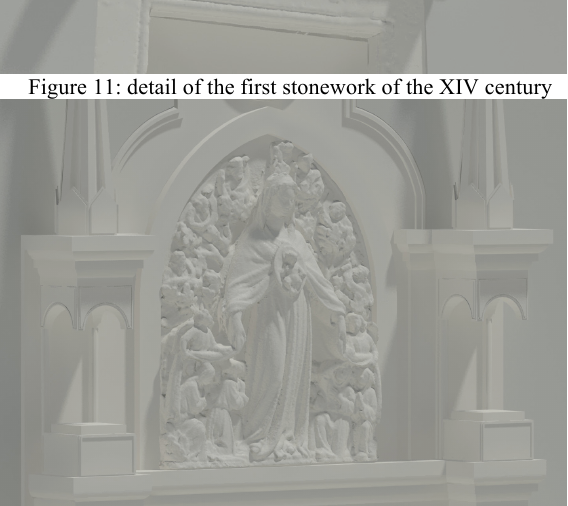
Figure 11: detail of the first stonework of the XIV century